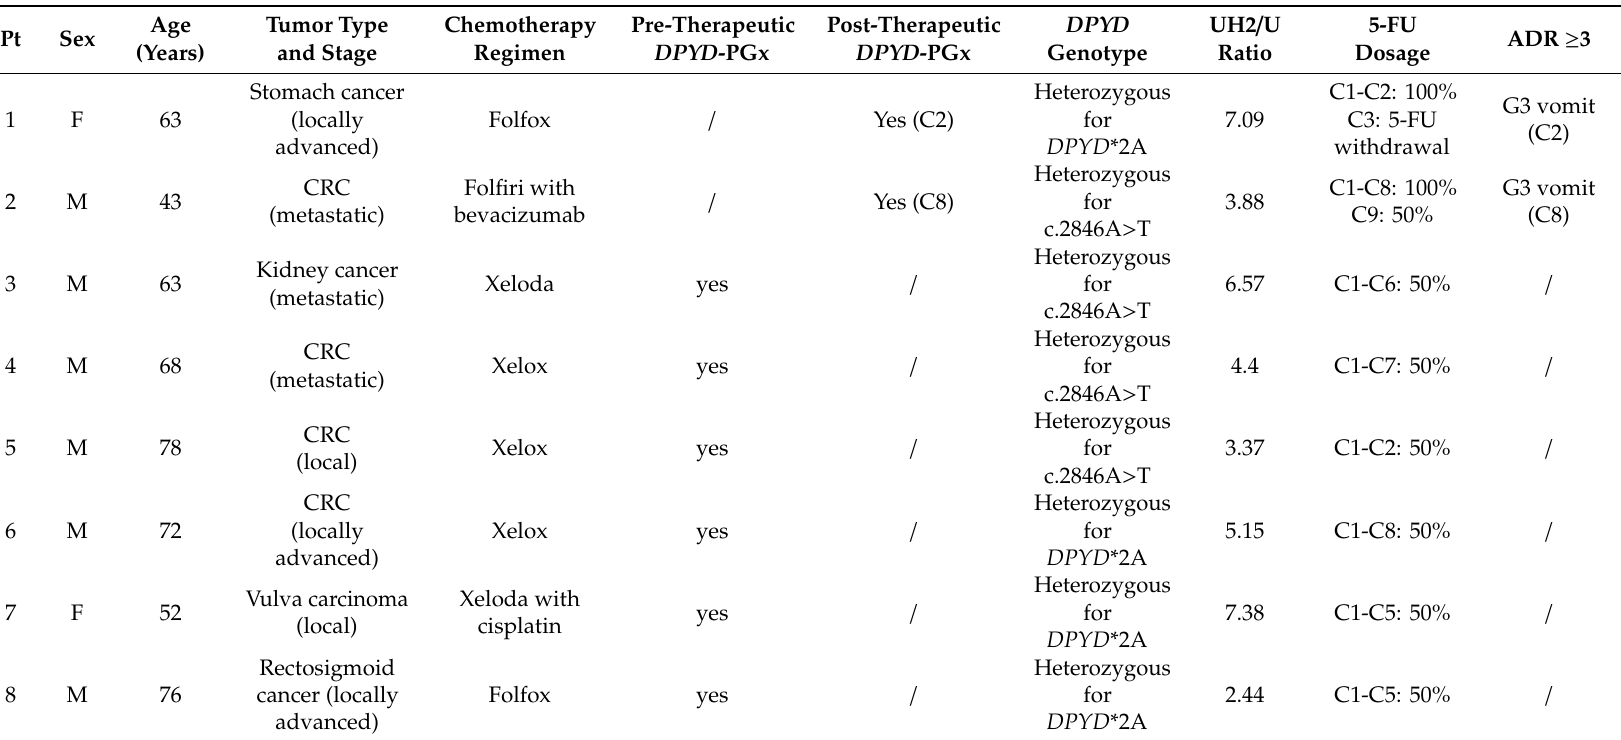
Table 2. Reports of 8 clinical cases for whom either pretherapeutic DPYD -PGx or post-therapeutic DPYD -PGx were performed. As phenotypic characteristics, the UH2 / U ratio values were